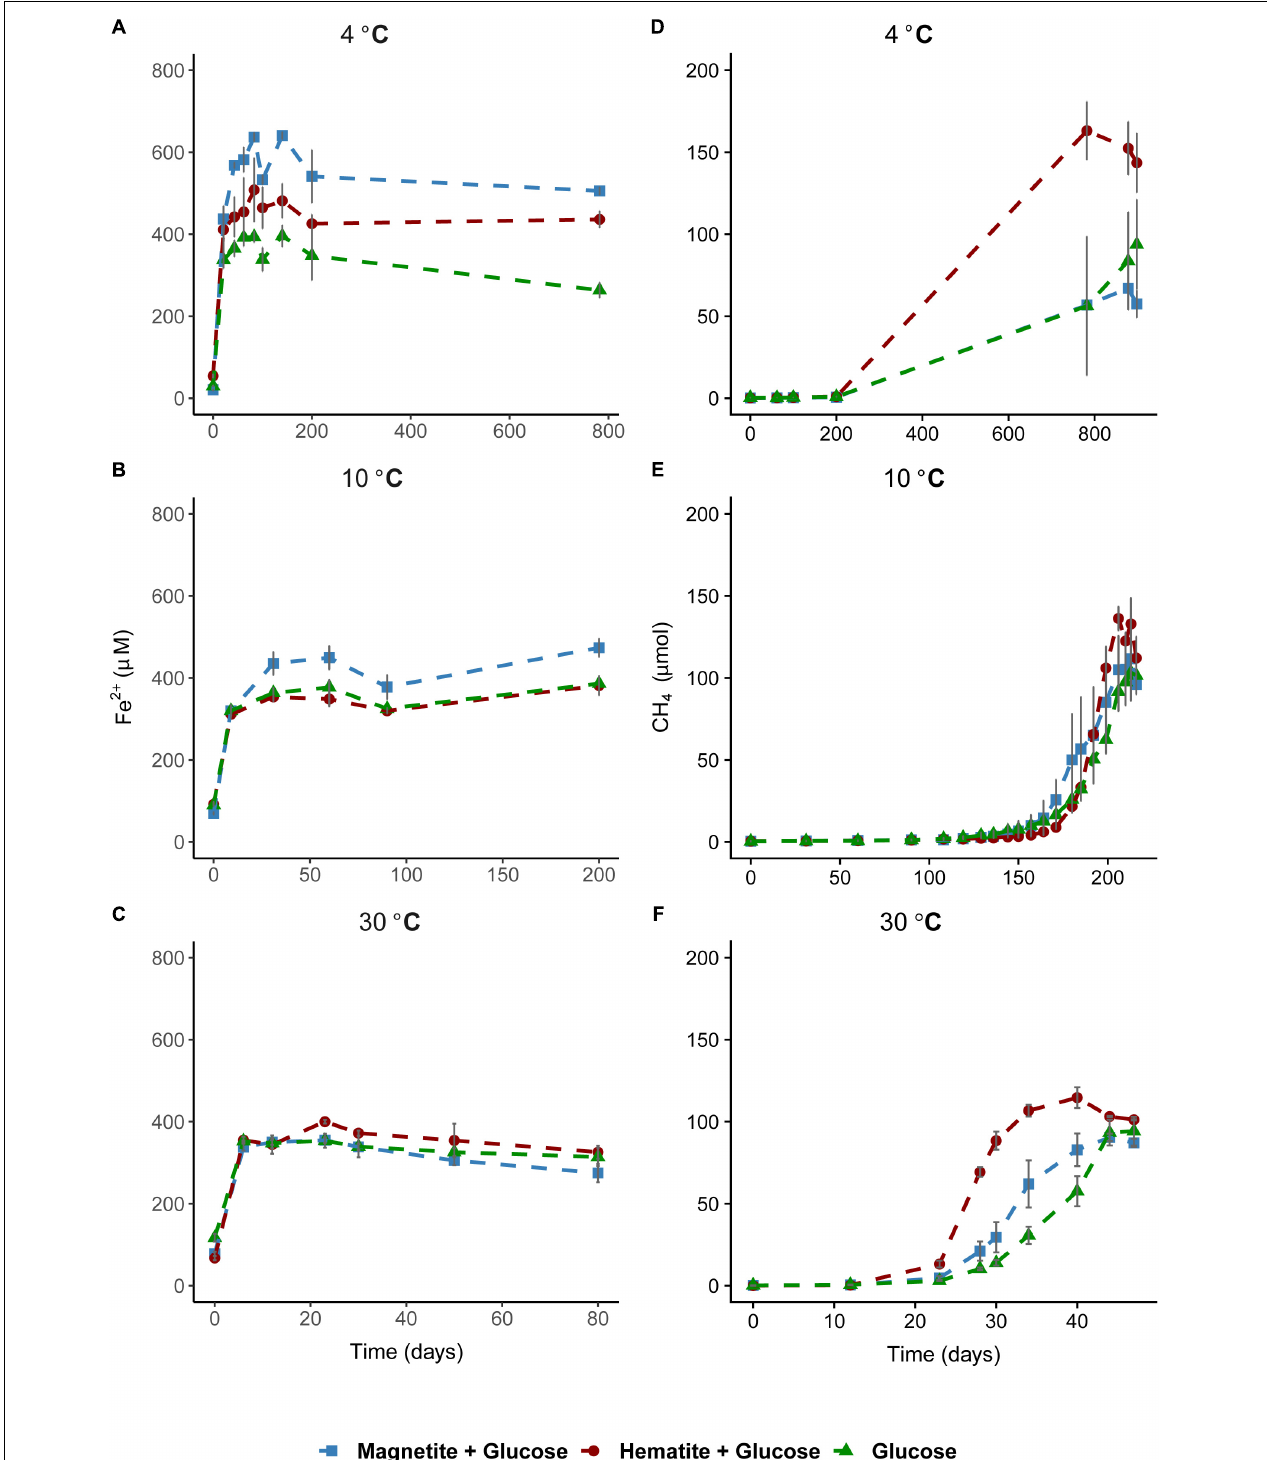
FIGURE 1 | Time course of iron reduction and methane formation in sediment incubations. Left column plots show time course of iron reduction at 4 ◦ C (A) , 10 ◦ C (B) , and 30 ◦ C (C) . Fe 2 + was measured over time until a stable concentration was observed in the aqueous phase across all temperatures. Right column plots show time course of methane formation at 4 ◦ C (D) , 10 ◦ C (E) , and 30 ◦ C (F) . In (A) , the 800-day time point was added to demonstrate that iron reduction was not on-going in the methanogenesis phase.